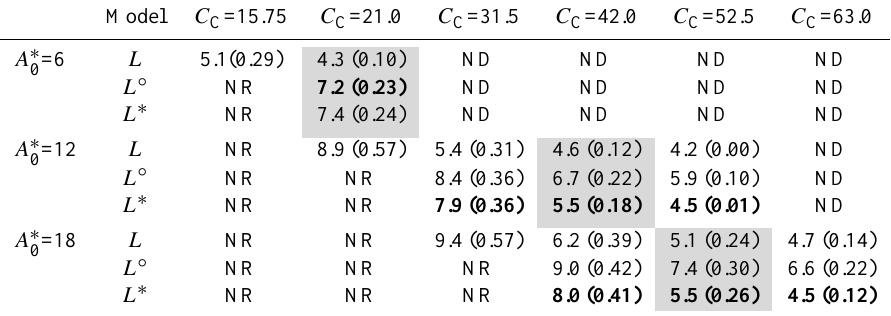
Table B1. Different potential “optimal” values of leaf area index and associated decay coefficients for photosynthetic capacity through the canopy, k P (in brackets) for various combinations of total canopy photosynthetic capacity, C C expressed in µmolm − 2 (ground area) s − 1 , and photosynthetic capacity for leaves at the top of the canopy in the absence of dark respiration, A ∗ , expressed in µmolm − 2 (leaf area) 0 s − 1 . Three values are given (in order); that where the photosynthetic productivity is maximised as in Fig. 4: i.e. with no consideration of “evolutionarily stable” strategies or the need for the light compensation point, for the lowest leaves to be greater than zero; L : that where the “evolutionarily stable” leaf area index has been estimated as in Eq. (B1); L ◦ : and that where the long term light compensation point is equal to zero (i.e. photosynthesis is exactly balanced respiration for the lowest leaves of the canopy over a 3.5 year period; L ∗ ). NR = “Not Reached” which means this point occurred above the maximum tested leaf area index of 10.0; ND = “Not Determined”, usually because the value of k P required to fulfill these simulations was < 0.0 (see text). Values in bold suggest the most likely values (see text) and lightly shaded cells correspond to the “optimal” solutions as shown in Fig. 4.